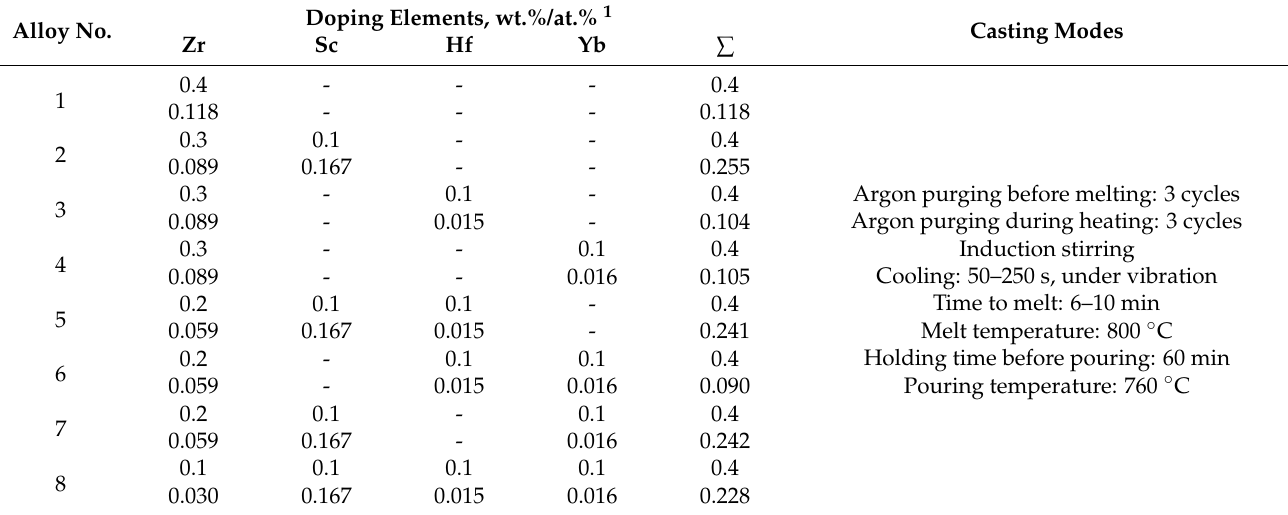
Table 1. Aluminum alloys: chemical composition and casting